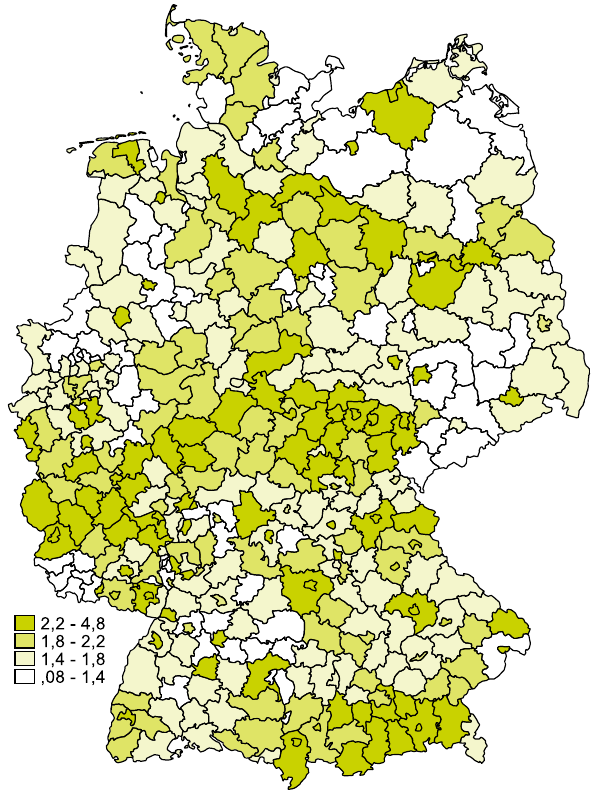
Figure 1: Newly founded associations per 1000 inhabitants between 2006 and 2016. Source: ZiviZ Survey 2017/Vereinsregister, authors ’